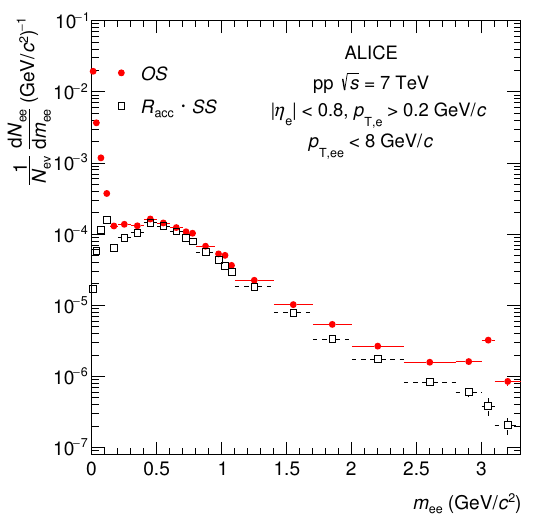
Figure 6 . Opposite-sign m ee -di(cid:11)erential yield integrated in p T ; ee and DCA ee overlaid with the same-sign spectrum corrected by the acceptance correction factor R acc . Statistical uncertainties are represented by vertical